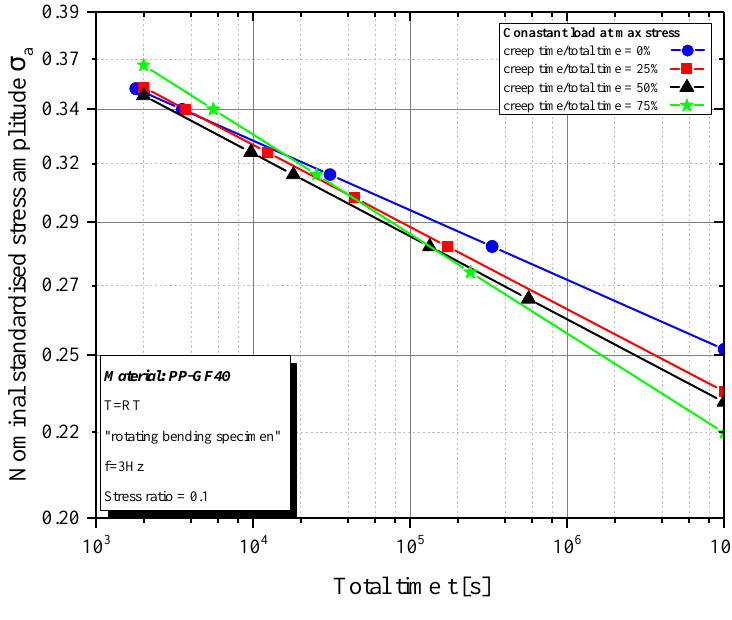
Figure 8. Time to failure for constant load at maximum